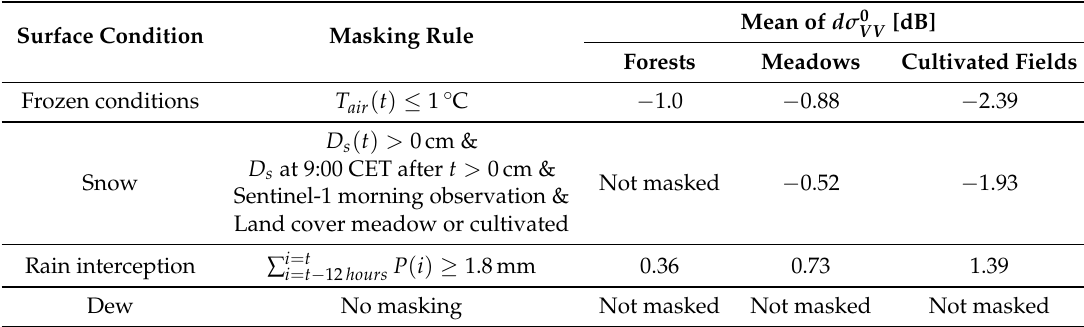
Table 4. The masking rules for the weather-related surface conditions that result from the analyses